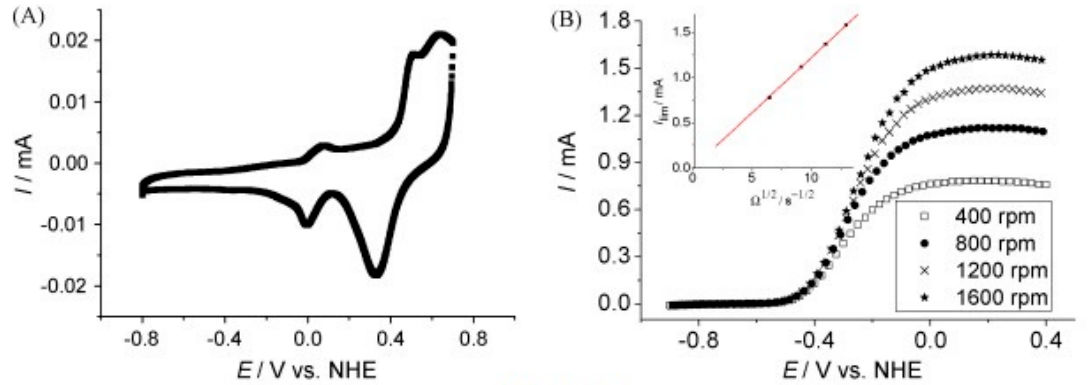
Figure 3. Cyclic voltammetry (CV) at the gold disk (0.124 cm 2 ) of the RRDE in ( A ) supporting electrolyte (1 M NaOH) for Ω = 0) and in ( B ) 0.1 M NaOH + 10 − 3 M NaBH 4 at 25 °C for several revolution rates ( Ω ) of the RDE. Reproduced from ref. [44] with permission from the publisher.